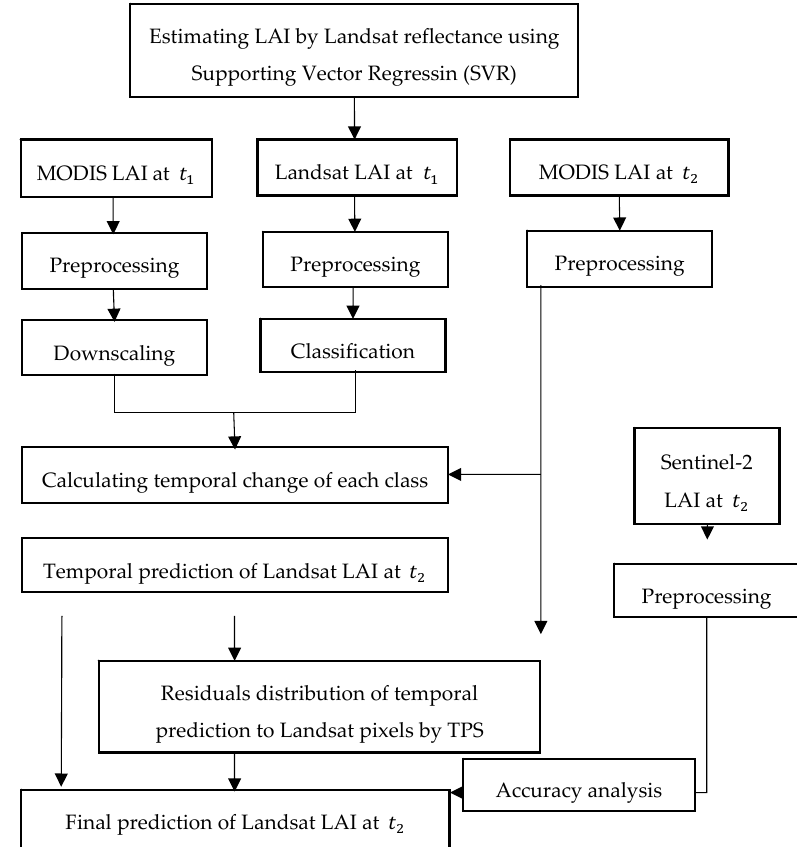
Figure 1. Flowchart of the modified Flexible Spatiotemporal Data Fusion (FSDAF) model.